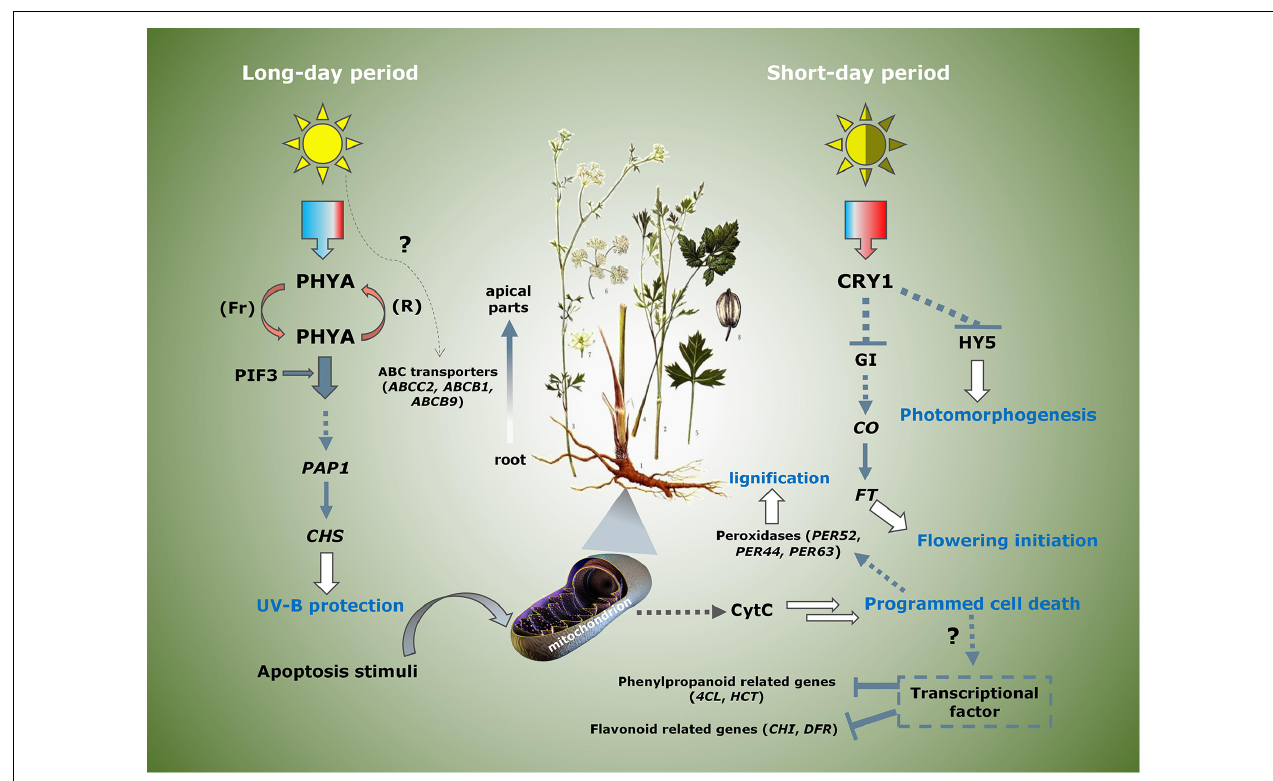
FIGURE 11 | A plausible model on the molecular mechanism of photoperiod regulating bolting and transformation of coumarins in P. praeruptorum . PHYA (TRINITY_DN77328_c0_g1), PIF3 (TRINITY_DN83313_c0_g2), PAP1 (TRINITY_DN63777_c0_g1, TRINITY_DN63757_c0_g2), CRY1 (TRINITY_DN82168_c0_g4, TRINITY_DN96996_c3_g1), GI (TRINITY_DN87544_c1_g2), CO (TRINITY_DN75433_c0_g3, TRINITY_DN94065_c2_g1), FT (TRINITY_DN110183_c0_g1, TRINITY_DN61953_c0_g1), HY5 (TRINITY_DN89278_c0_g1, TRINITY_DN5919_c0_g1), CHS (TRINITY_DN70261_c1_g1, TRINITY_DN91517_c0_g1, TRINITY_DN80066_c0_g1), CytC (TRINITY_DN69779_c1_g2, TRINITY_DN70114_c2_g1).